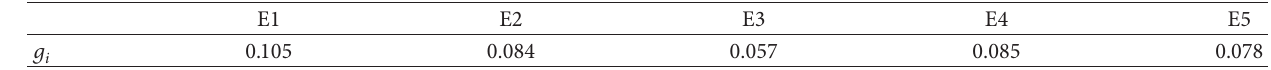
Table 9: Boundary approximation area